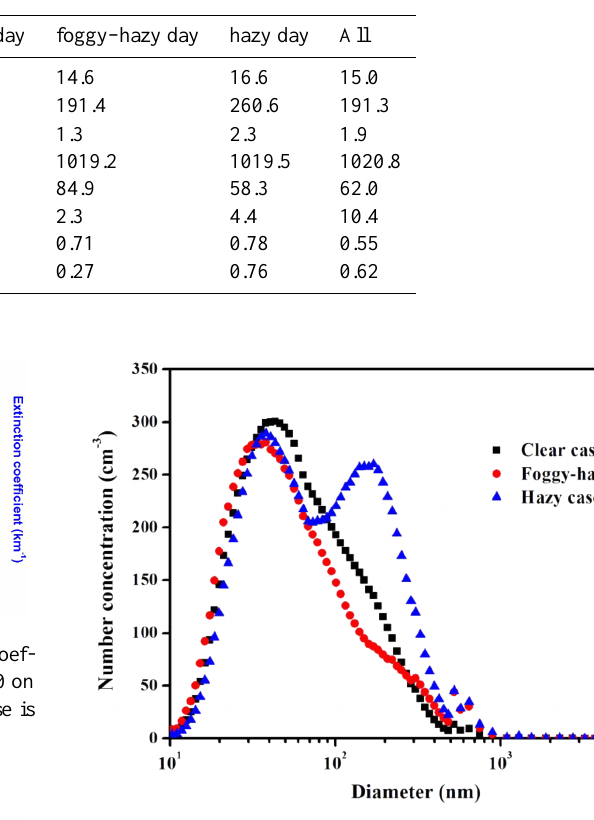
Figure 5. Average size distributions (10nm–10µm) for all the hazy, foggy–hazy, and clear